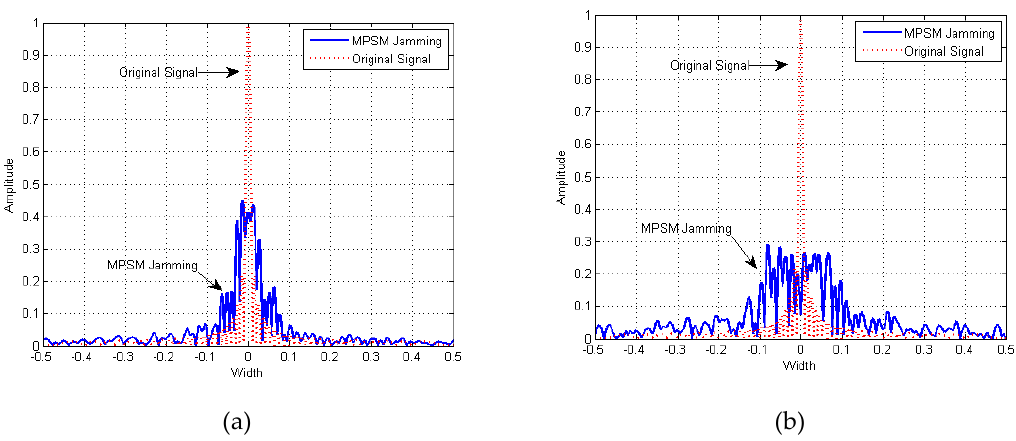
Figure 18. MPSM jamming with optimized section situation and phase situation: ( a ) four sections and ( b ) 16 sections. Table 13. Results of MPSM jamming in Figure 18.